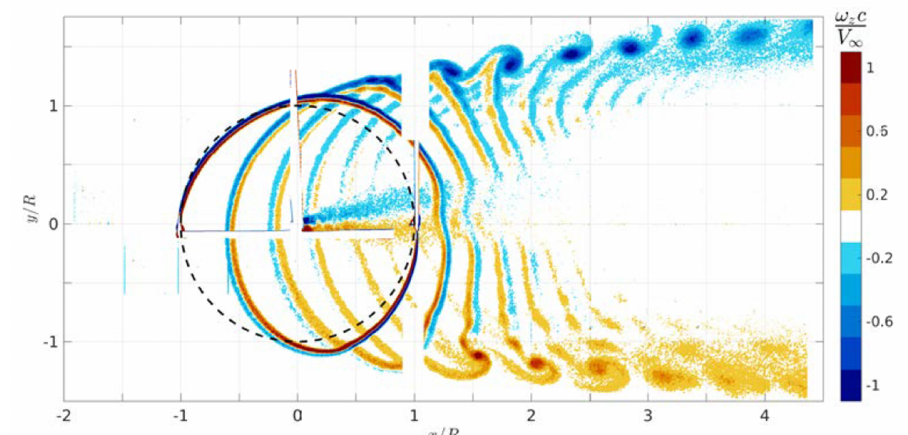
Figure 8. Contour plot of vorticity (out of plane) at the equatorial plane of a three straight-bladed VAWT. Results are obtained from Stereo Particle Image Velocimetry (SPIV) measurements. This provides a clear picture of how shed vorticity distributes itself particularly towards the wake edges. Image courtesy of Tescione [53].